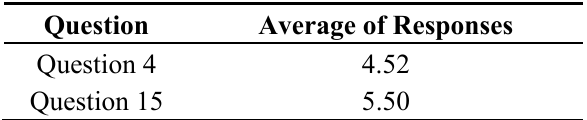
Table 20. Comparison of Question 4 and 15